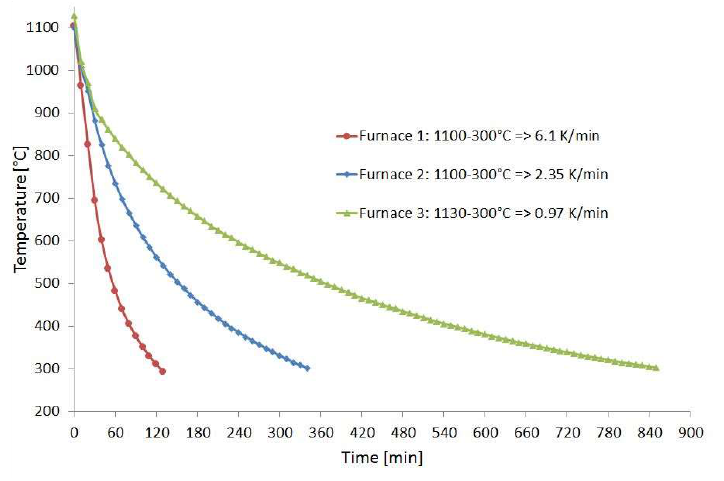
ff usion bonding furnaces.